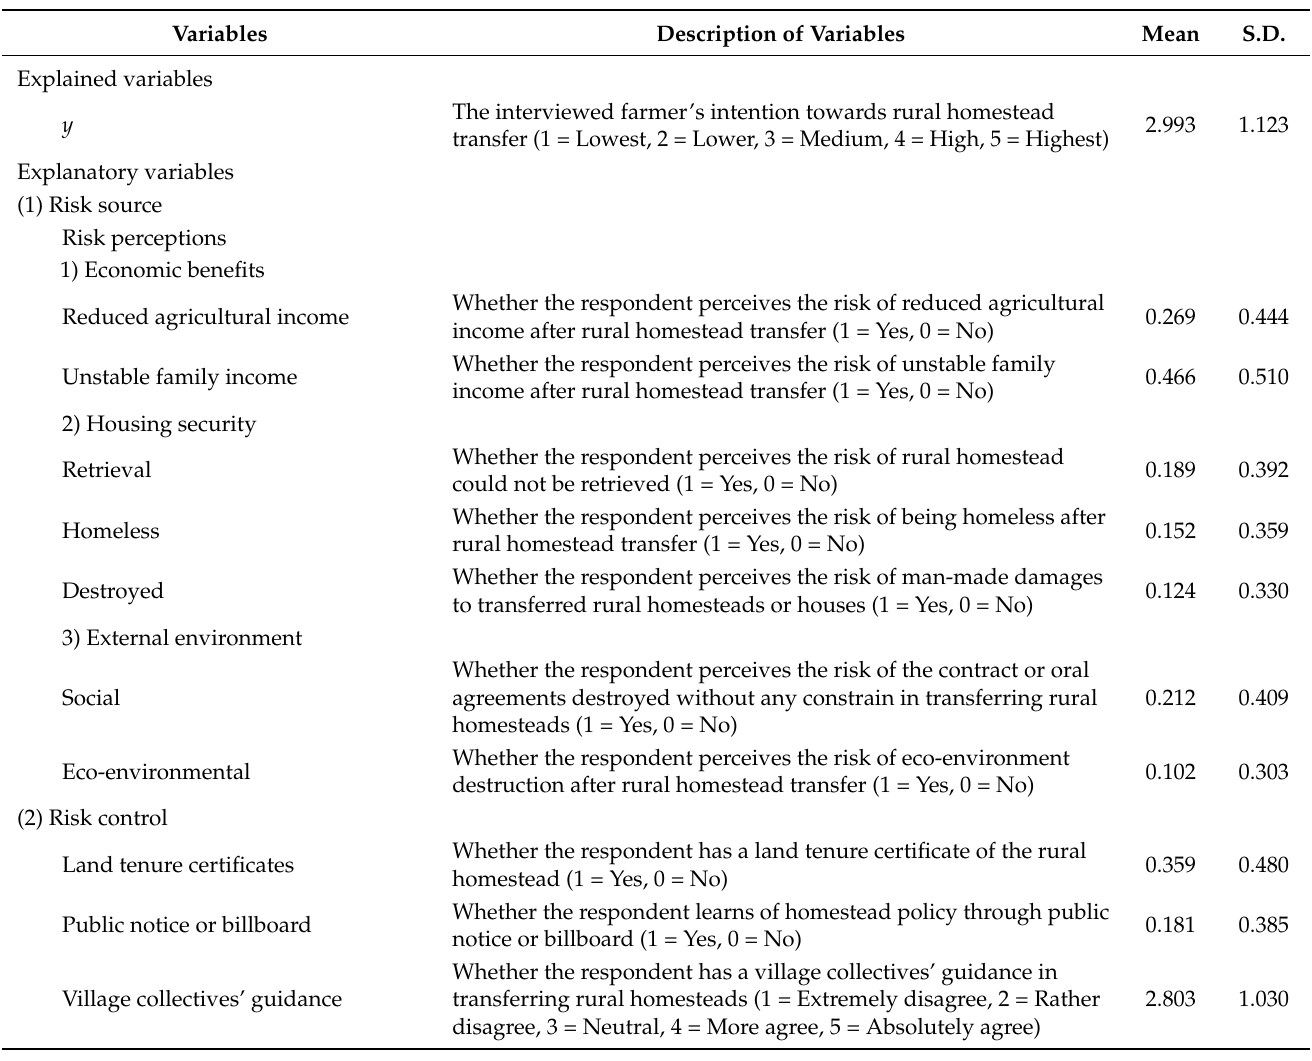
Table 2. Model variables